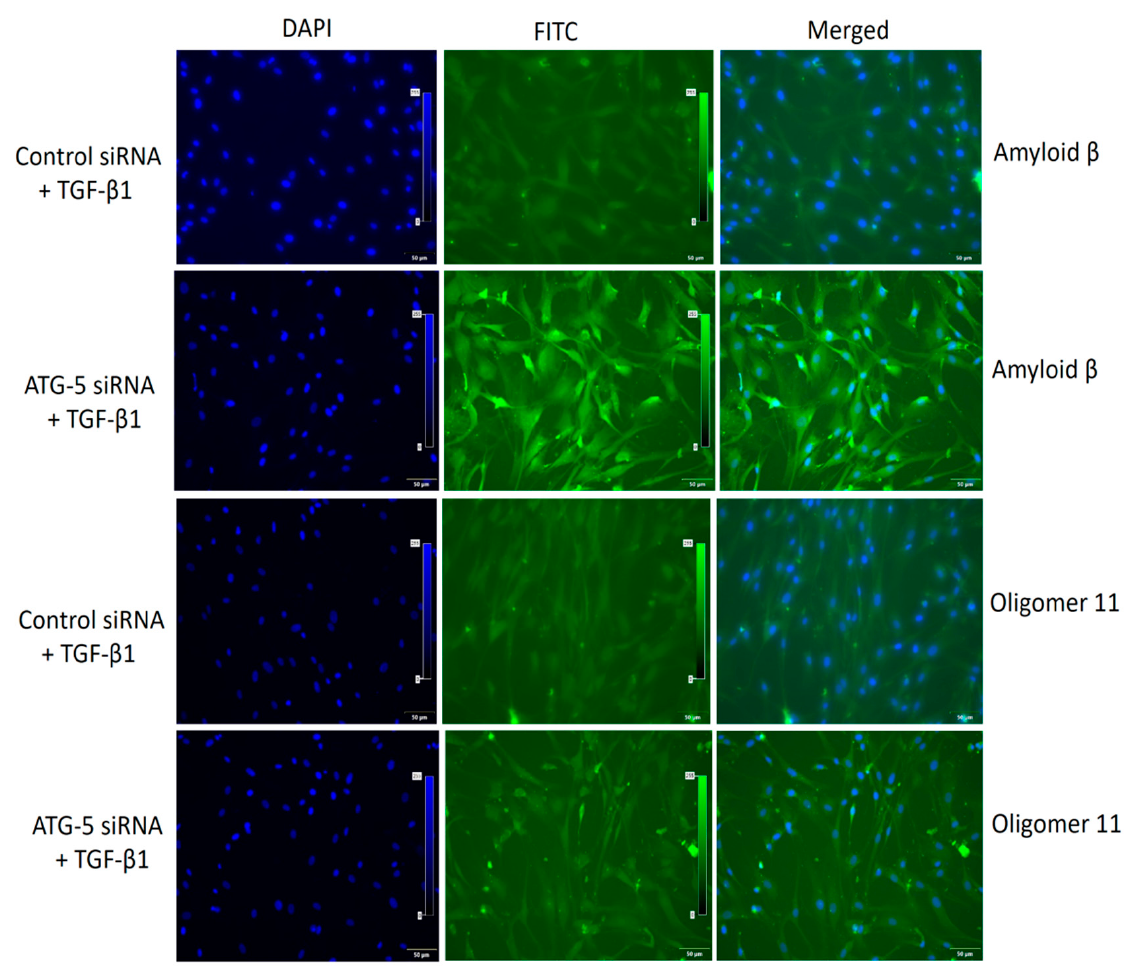
Figure 7. Transforming growth factor, TGF induced ATG5 activation plays a crucial role in preventing TGF induced aggregate formation in HTM cells. Amyloid fibrils were found around and closer to the nucleus and oligomer 11 was spread throughout in siATG5 cells exposed to 10 ng/mL TGF- β 1. Magnification 20×, Bar = 50 µM.